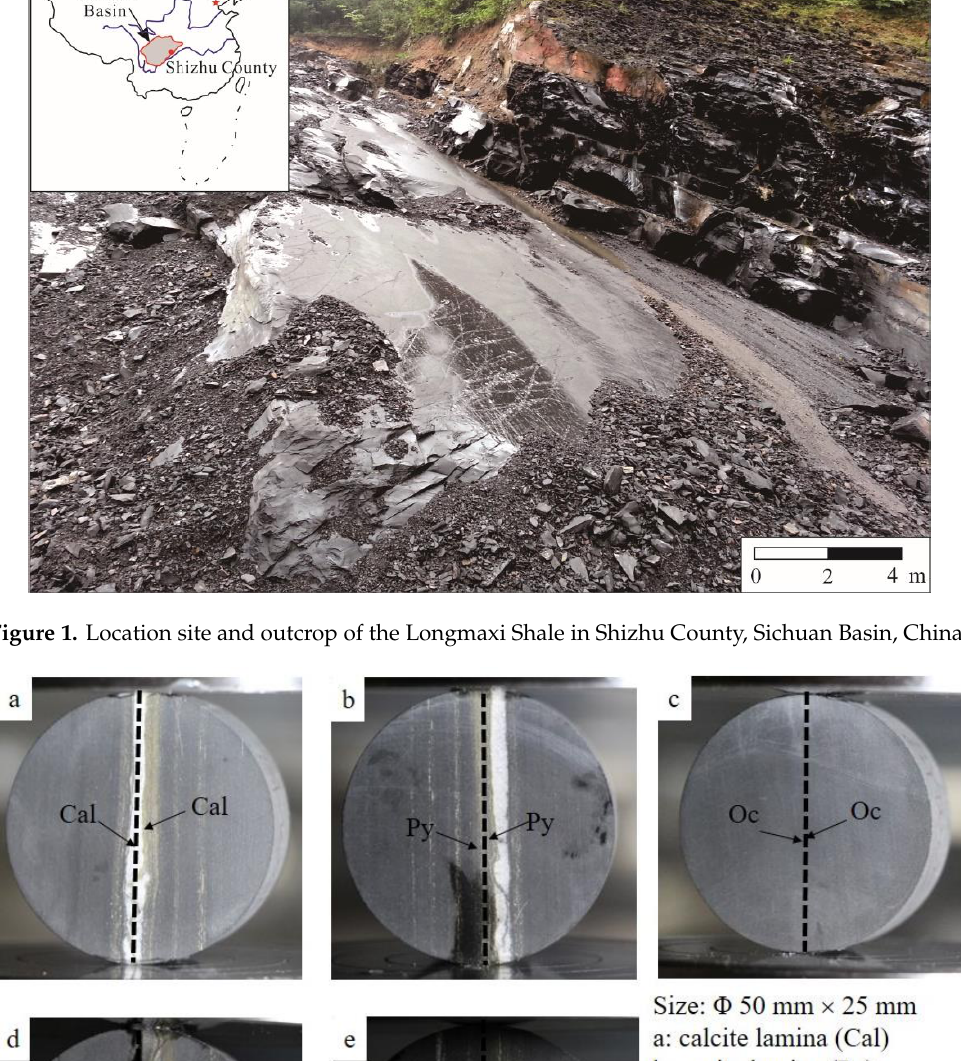
Figure 1. Location site and outcrop of the Longmaxi Shale in Shizhu County, Sichuan Basin, China.